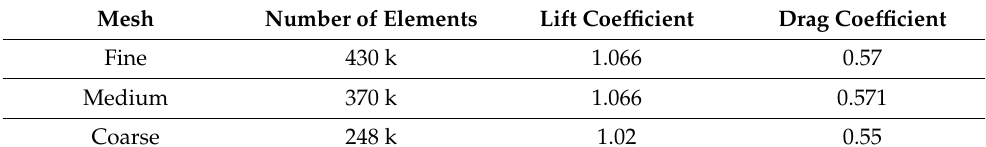
Table 5. Mesh sensitivity study.